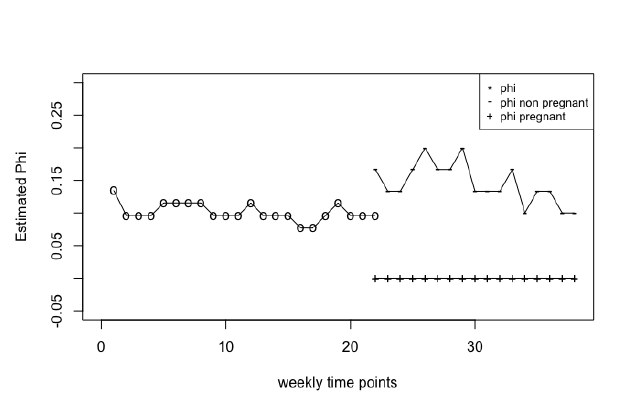
Figure 5. Change of ˆ φ estimate over 38